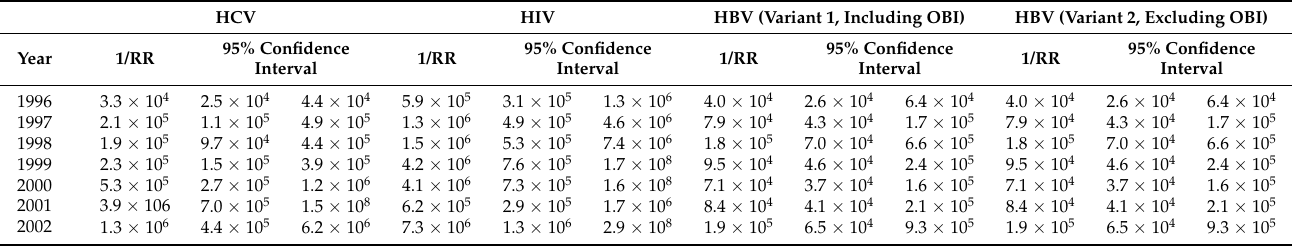
Table A1. Theoretical calculated inverse of the RR for HCV, HIV and HBV from 1996 to 2021, including the 95% confidence